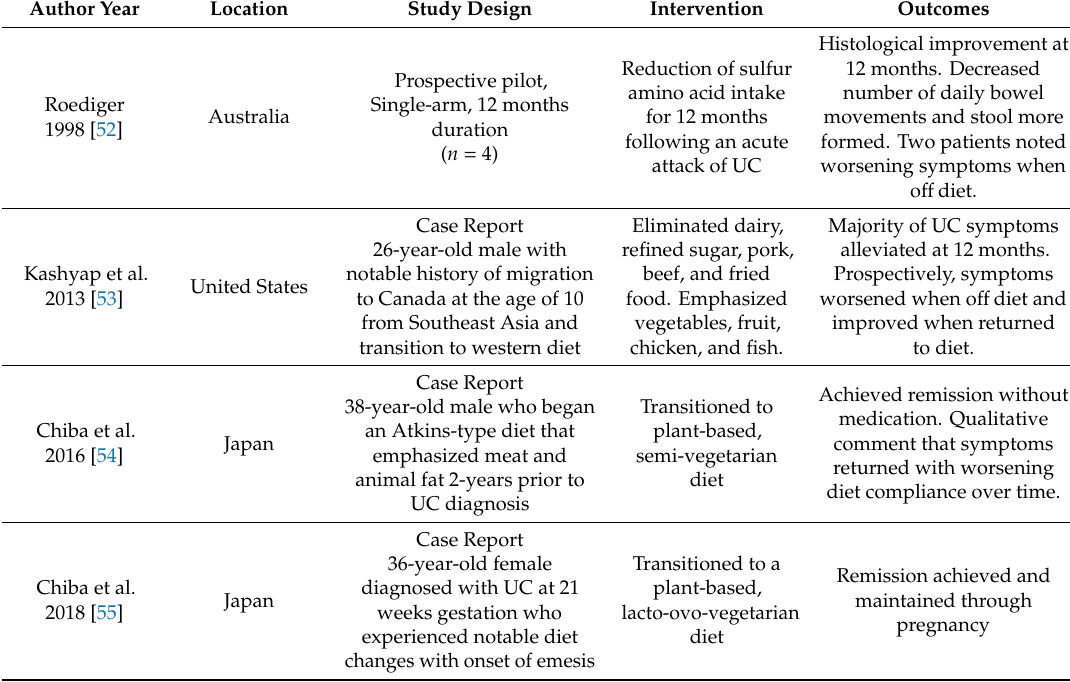
Table 1. Summary of reports detailing dietary interventions in the treatment of ulcerative colitis (UC) targeting the updated H 2 S